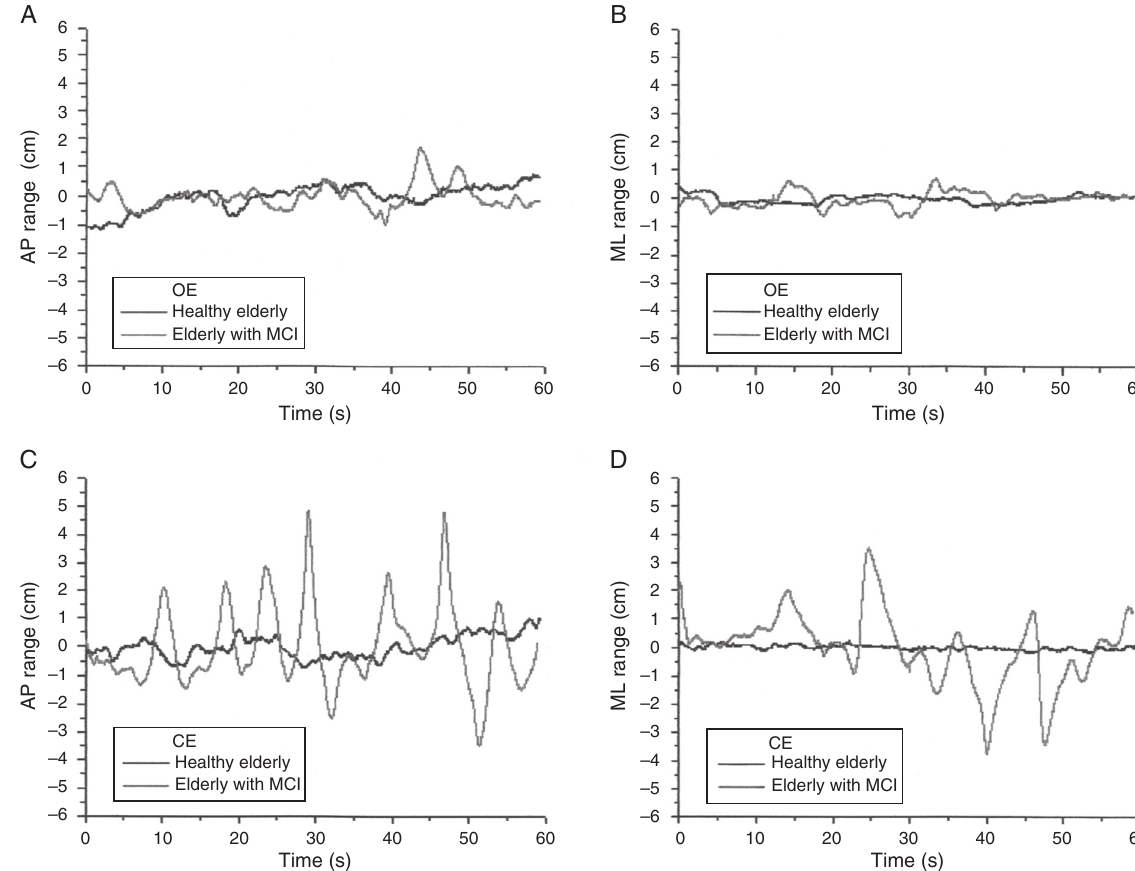
Figure 3 Stabilogram from a healthy elderly and from one with mild cognitive impairment (MCI). Open eyes (OE) in an anteropos- terior (AP) direction. B, open eyes (OE) in a mediolateral (ML) direction. C, eyes closed (EC) in an anteroposterior (AP) direction. D, eyes closed (EC) in a mediolateral (ML)